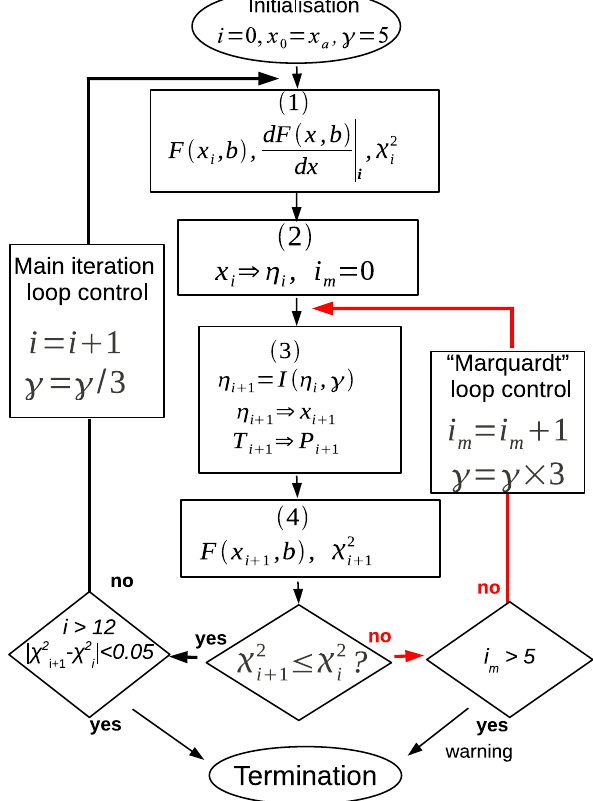
Fig. 3. Flowchart of the iterative inversion calculation. Step 1: the forward model and its Jacobian matrix, and the cost function (Eq. 2) are computed. Step 2: the retrieved parameters are scaled (Eq. 4) and the Marquardt loop counter is set to 0. Step 3: the inversion is performed (Eq. 5), the retrieved parameters are unscaled, and the pressure is derived from the retrieved temperature (Eq. 8). Step 4: the forward model and the cost function are estimated with the last estimate of the parameters. If the cost function decreases, the path is indicated by the black branch indicates the Gauss-Newton iteration loop including the decrease of the Levenberg/Marquardt parameter value. Otherwise, the Marquardt loop branch is used (red branch) where the Marquardt parameter γ is increased.